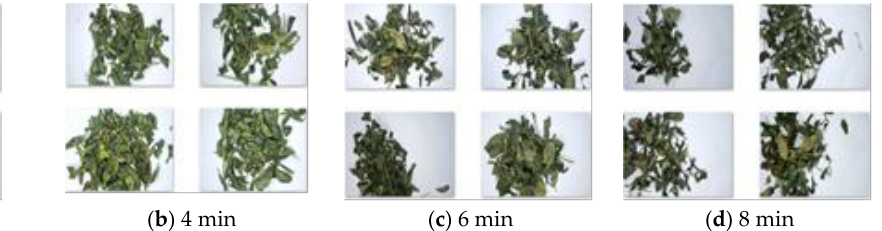
Figure 10. Training samples with different fixation time.